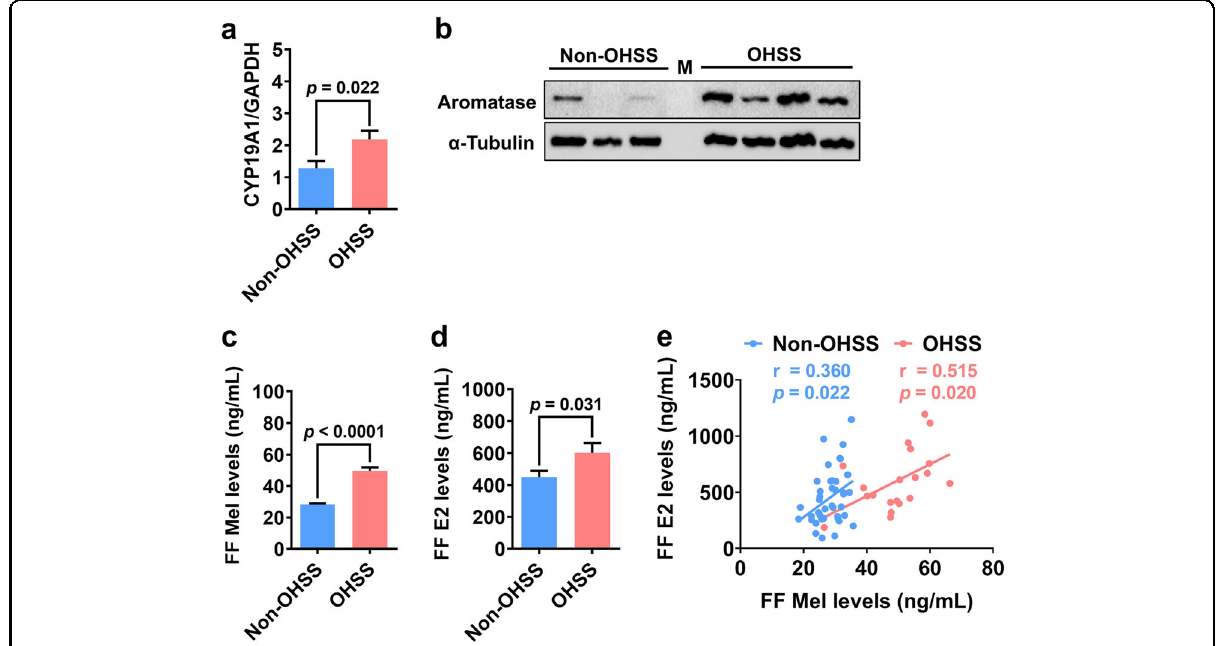
Fig. 5 Aromatase expression and melatonin and E2 levels in the follicular fl uid are increased in OHSS patients. a Aromatase mRNA levels (CYP19A1) in hGL cells from non-OHSS ( n = 8) and OHSS patients ( n = 8) were examined by RT-qPCR. b Aromatase protein levels in hGL cells from non-OHSS ( n = 3) and OHSS patients ( n = 4) were examined by western blotting. M: protein marker. c , d Melatonin ( c ) and E2 ( d ) levels in the follicular fl uid of non-OHSS ( n = 40) and OHSS ( n = 20) patients were examined by ELISA. e Pearson ’ s correlation analysis was performed to evaluate the correlation between two values. Melatonin levels were positively correlated with E2 levels in the follicular fl uid of non-OHSS ( n = 40) and OHSS patients ( n = 20). The results are expressed as the mean ± SEM. Values without a common letter are signi fi cantly different ( p <